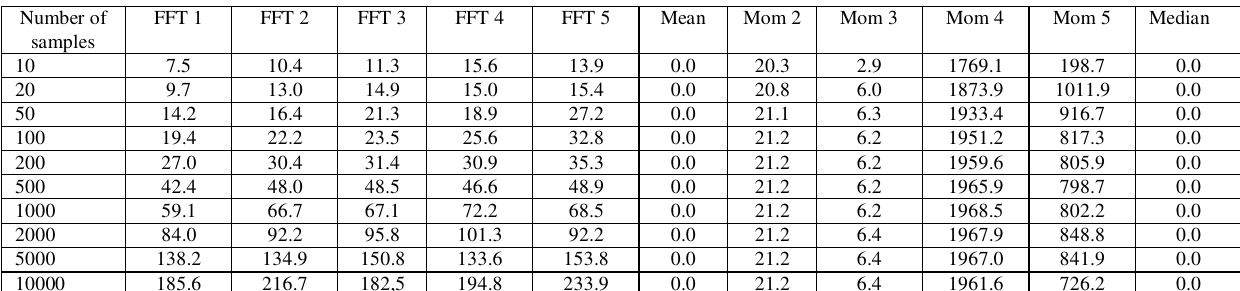
Table 1. Dependency of cluster center coordinates obtain using HCM algorithm on number of samples in a window (locomotive ST44-2045 after repair) Number of samples